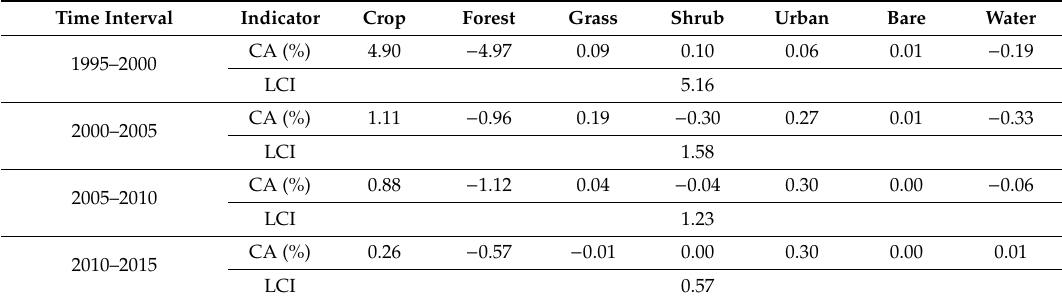
Table 4. Landscape change index (LCI) in Jiangxi province from 1995 to 2015.